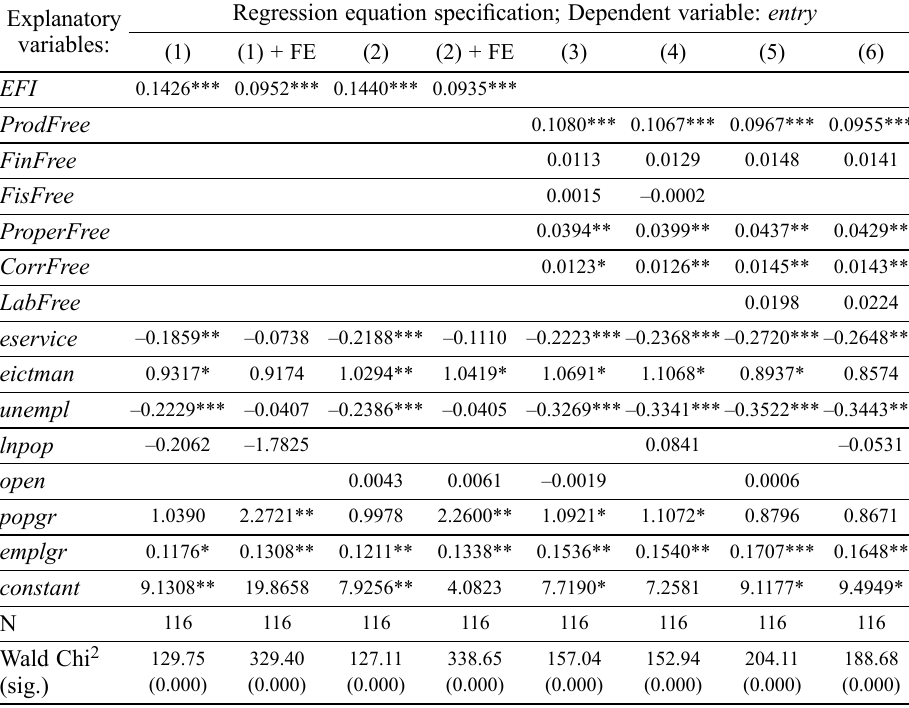
Table 1. Results of the regression